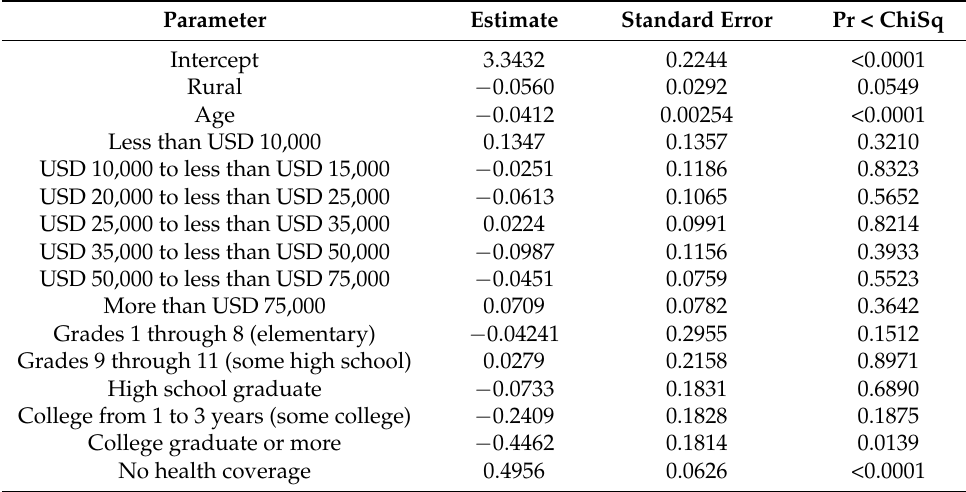
Table 2. Parameter estimates for not receiving influenza vaccine in the past year.